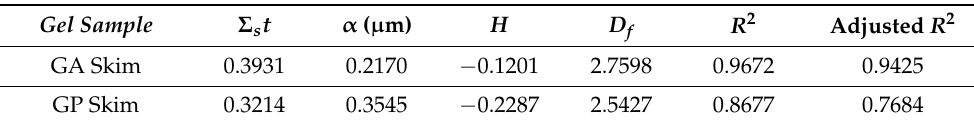
Table 4. Structural parameters and goodness of fits for the fractal network of casein micelles (CM) in the deuterated skim milk gels.